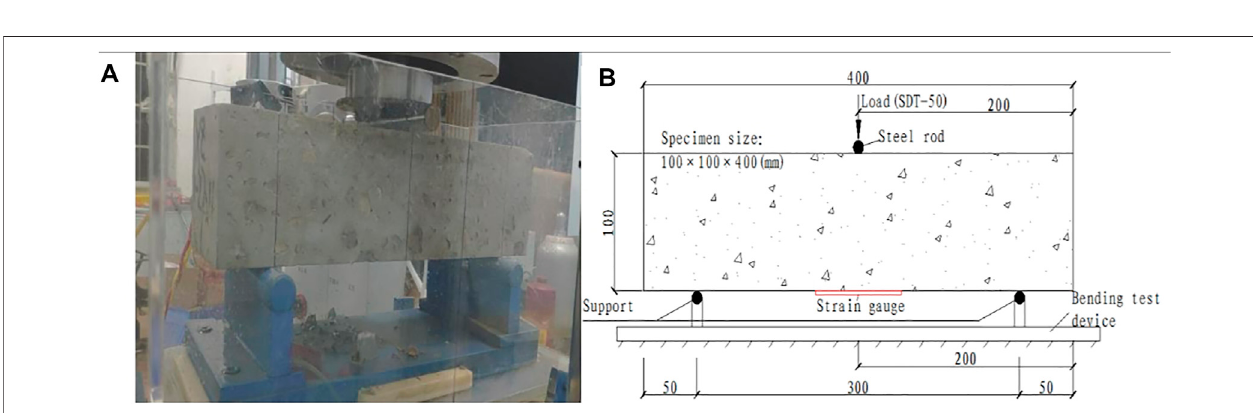
Frontiers in Earth Science |